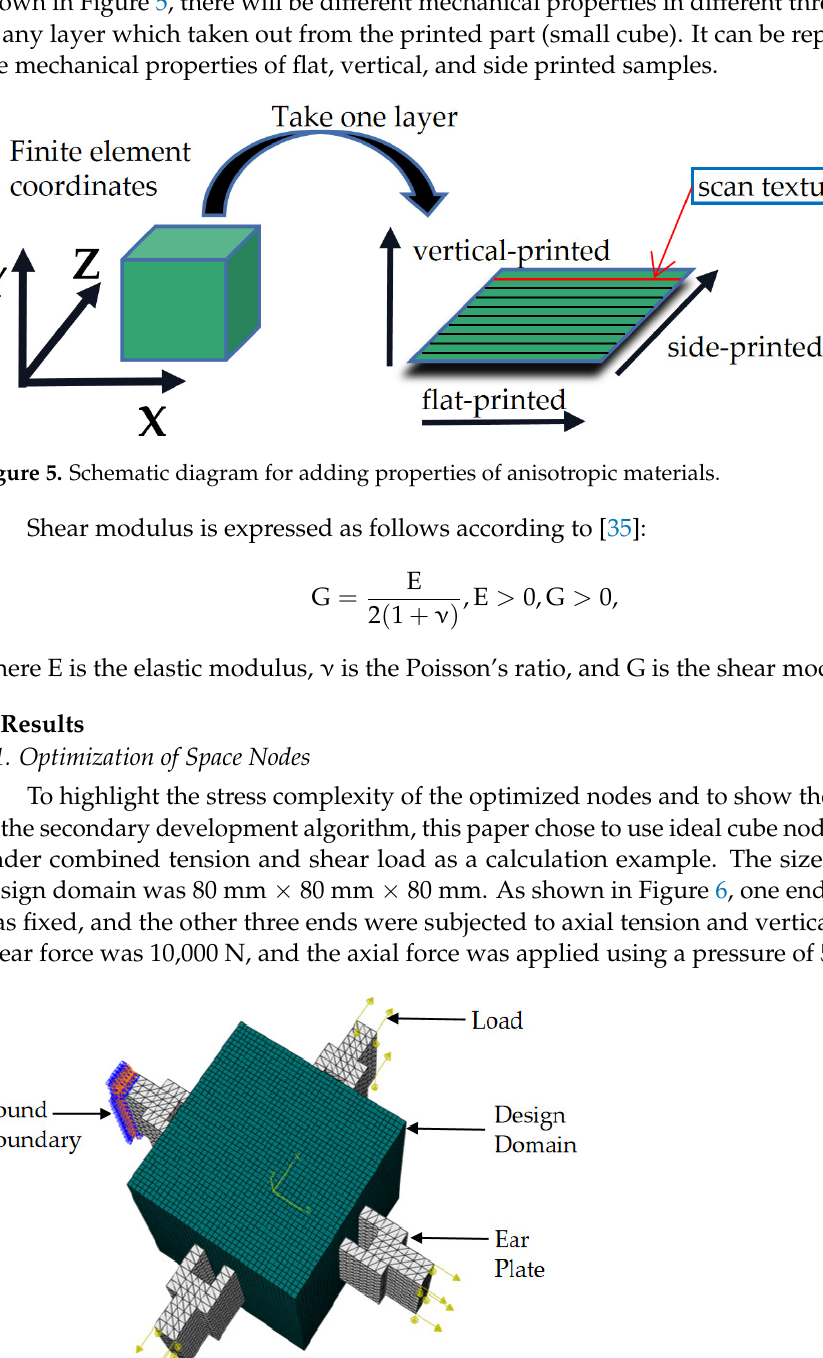
( b ) Figure 7. Isotropic topology optimization results: ( a ) stress contour; ( b ) iterative curve. Therefore, the BESO secondary development procedure was reasonably reliable. 3.2. The 316L Stainless-Steel Tensile Test Results As shown in Figure 8, the instrument used for the tensile test was the German Zwick electronic universal testing machine. Tensile tests were performed on nine samples in turn. The speed used in this test was 2 mm/min.